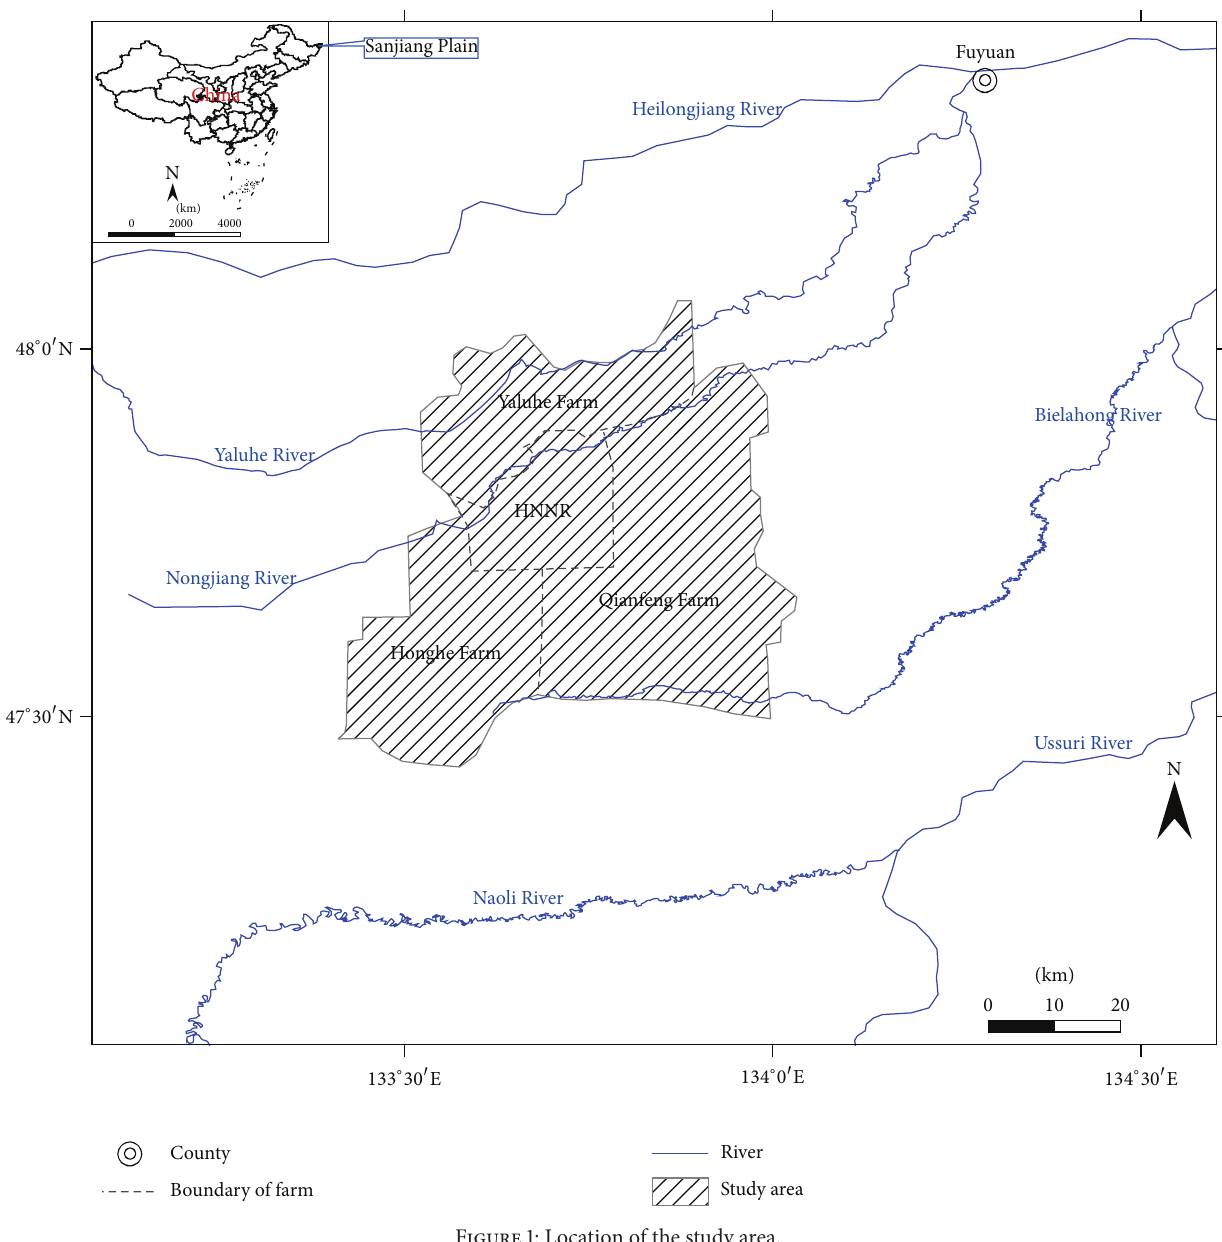
Figure 1: Location of the study